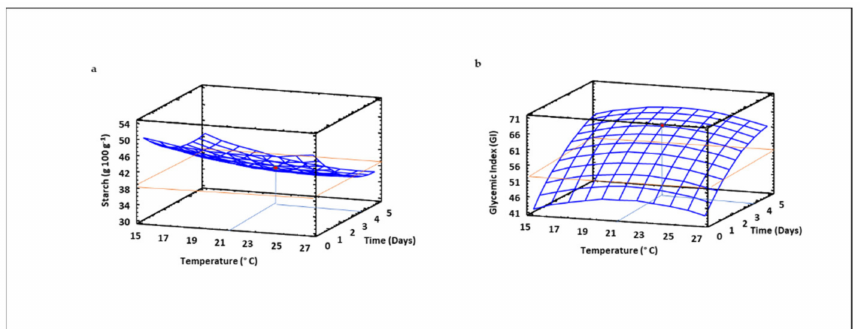
Figure 10. Three-dimensional response surface plots for the content of starch ( a ) and the glycemic index ( b ) as a function of the interaction between germination temperature and time. The red line corresponds with the control (ungerminated seed) and the red point with the value for optimum conditions (21 ◦ C and 3.5